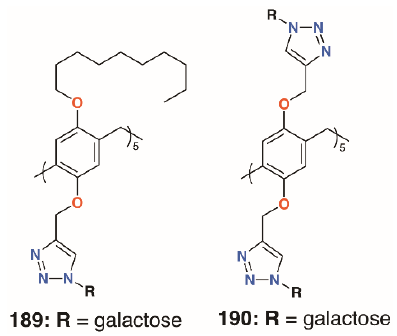
Figure 31. Huang’s glycosylated pillar[5]arenes.